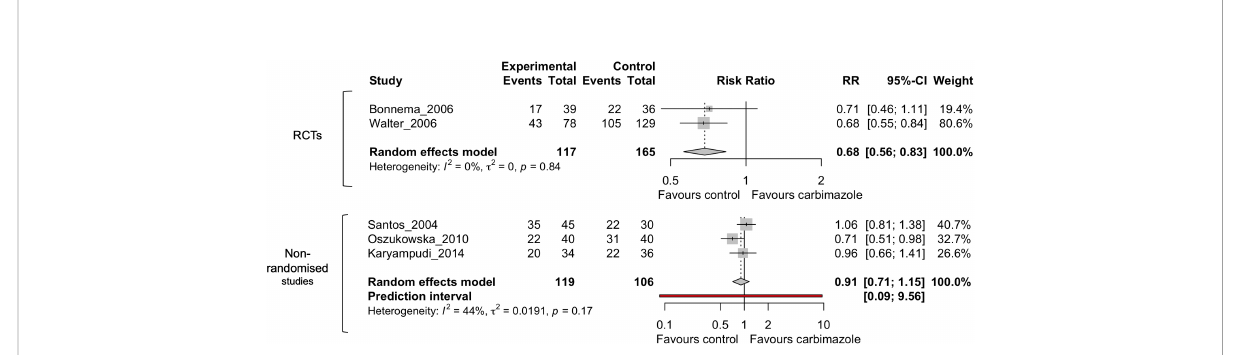
FIGURE 3 Random effects meta-analysis of carbimazole/methimazole studies divided into randomized control trials (RCTs) and non-randomized studies that considered cure after radioactive